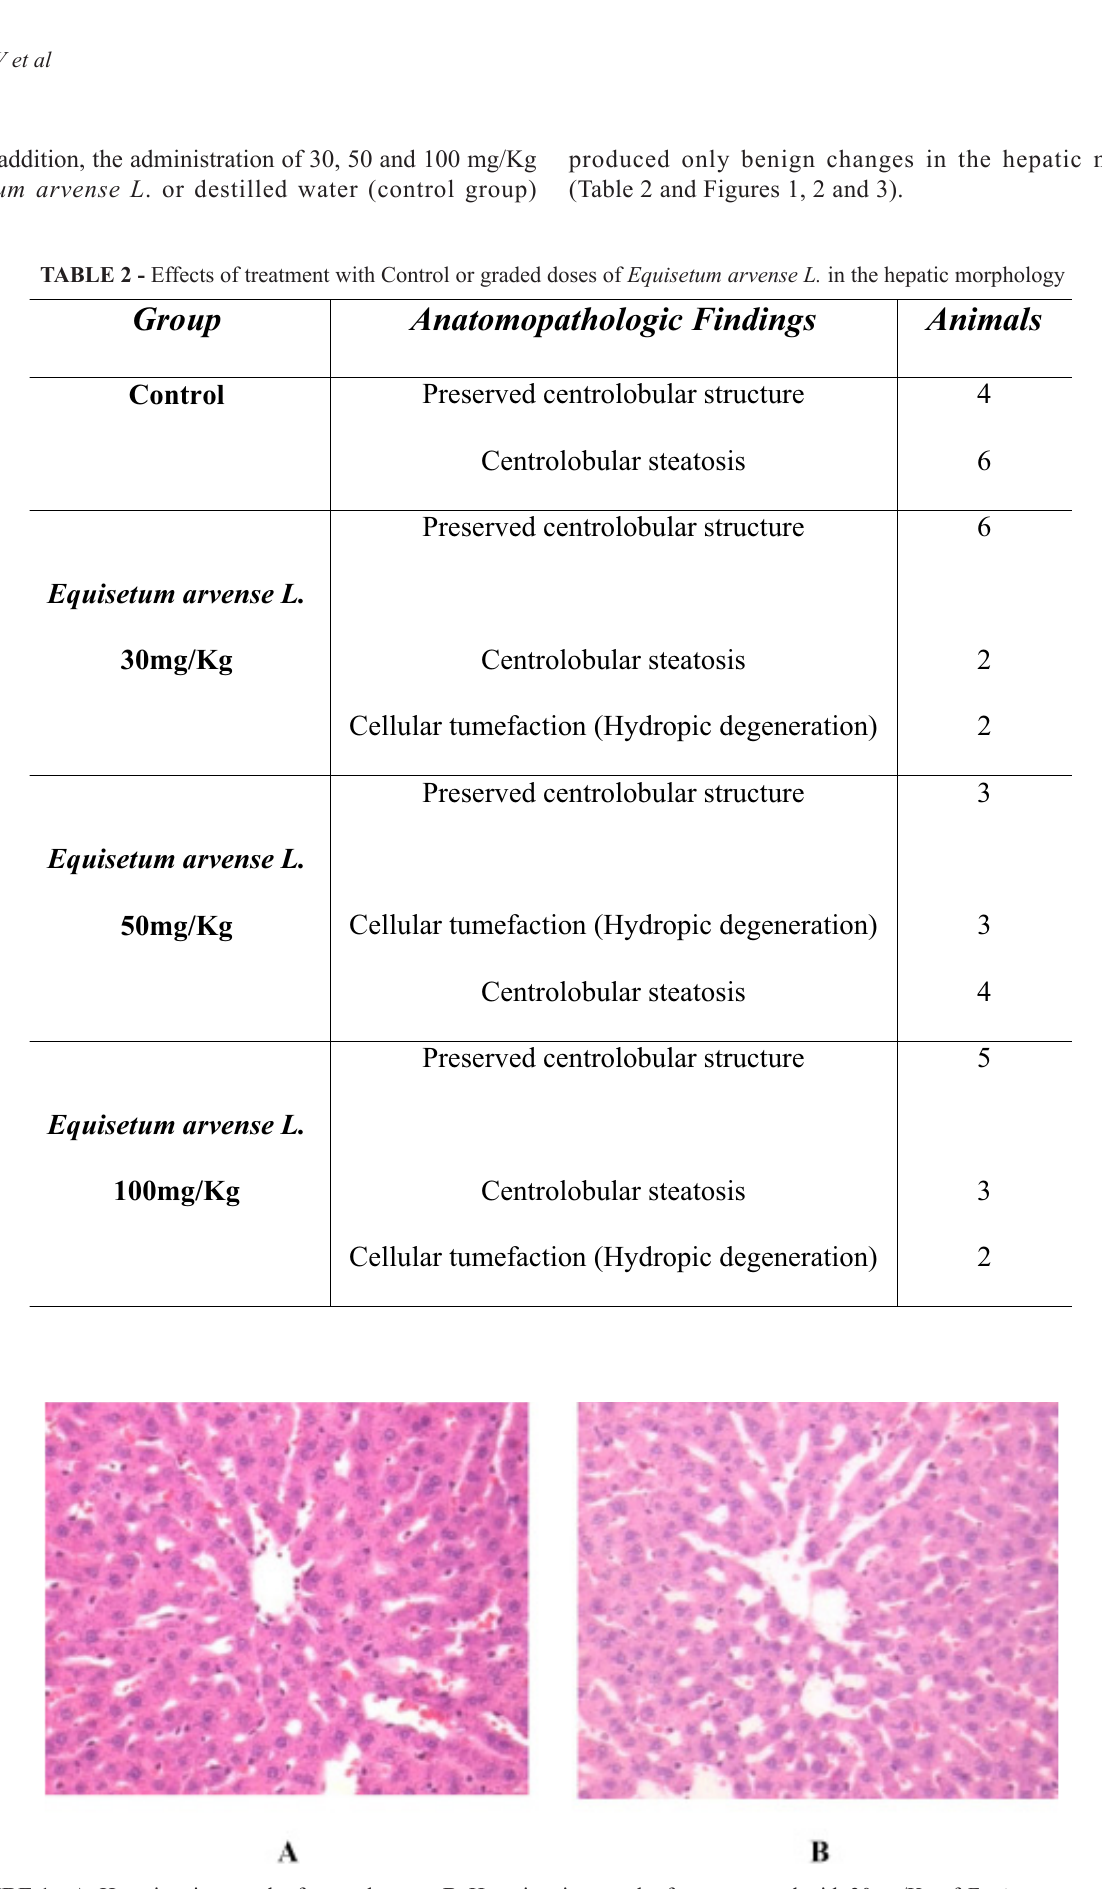
FIGURE 1 – A . Hepatic micrograph of control group. B. Hepatic micrograph of group treated with 30mg/Kg of Equisetum arvense